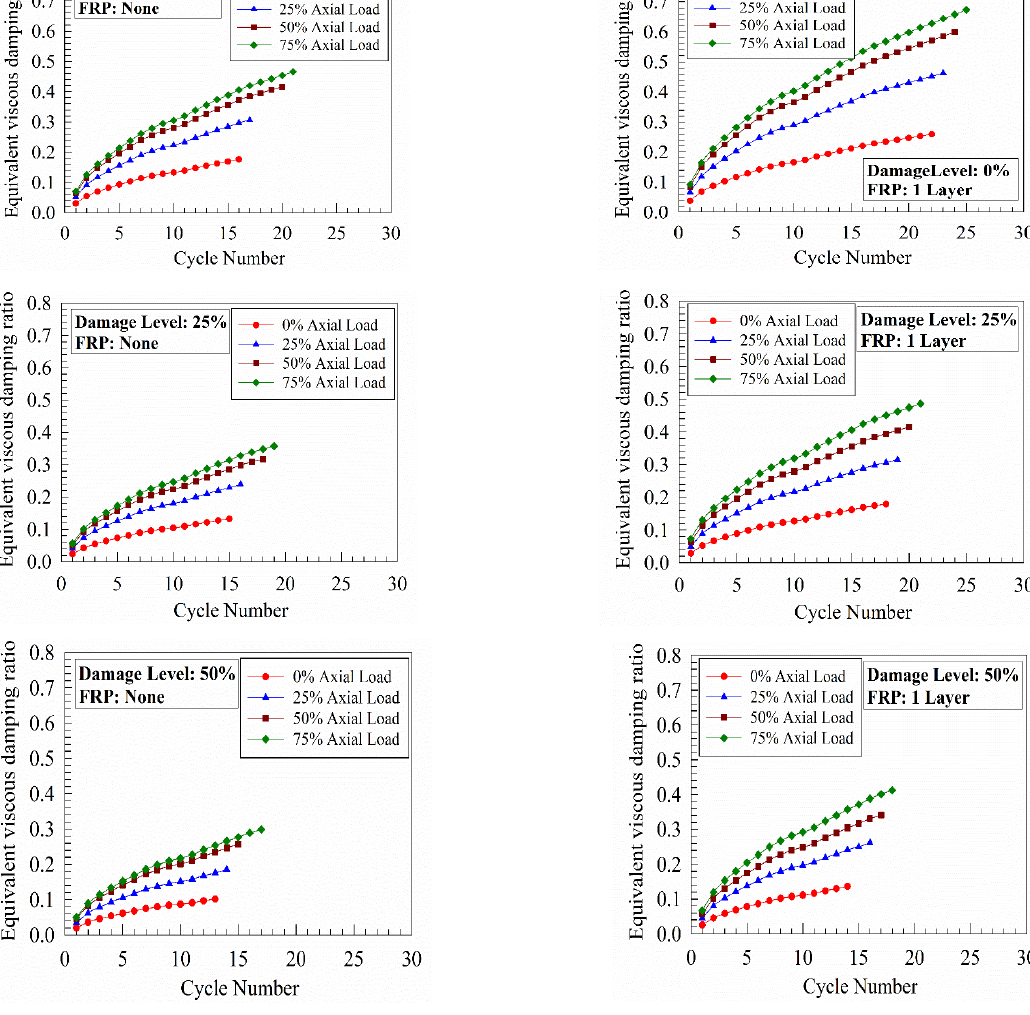
Figure 16. The equivalent damping ratio